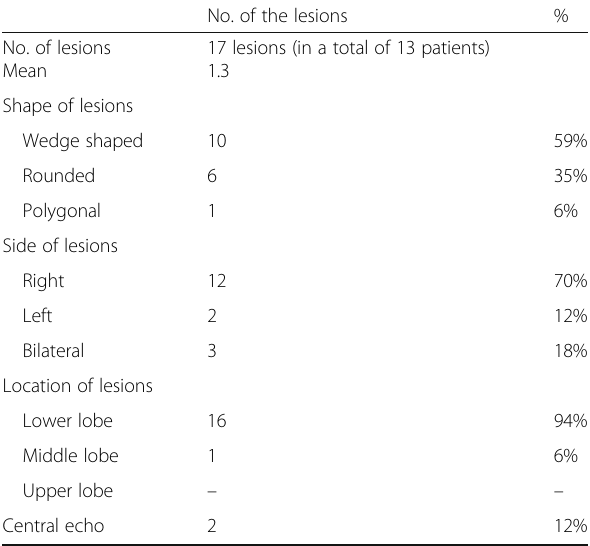
Table 4 A description of the lesions suggestive of PE by thoracic ultrasound and their number and percent